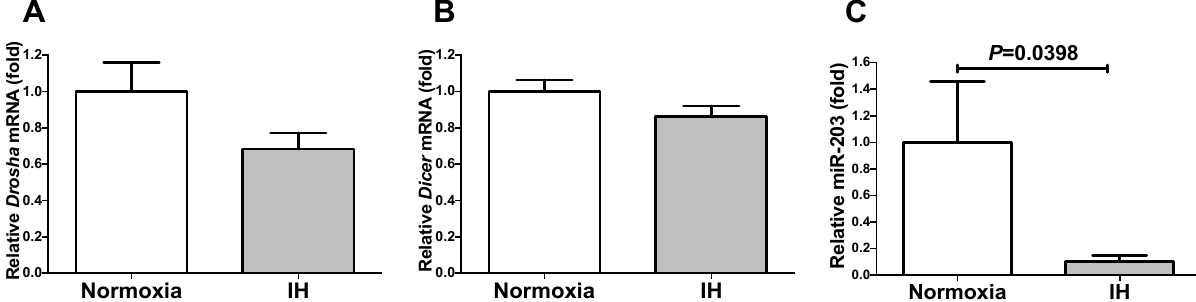
Figure 9. The levels of the Drosha mRNA ( A ), Dicer mRNA ( B ), and miR-203 ( C ) of the As4.1 JG cells subjected to normoxia or IH for 24 h. The levels of the Drosha and Dicer mRNAs and the miR-203 were measured by means of a real-time RT-PCR using Rig/RpS15 (for the Drosha/Dicer) or U6 (for the miR-203) as an endogenous control. The data are expressed as the mean ± SE for each group of six independent experiments (n = 6). The statistical analyses were performed using a Student’s t -test.